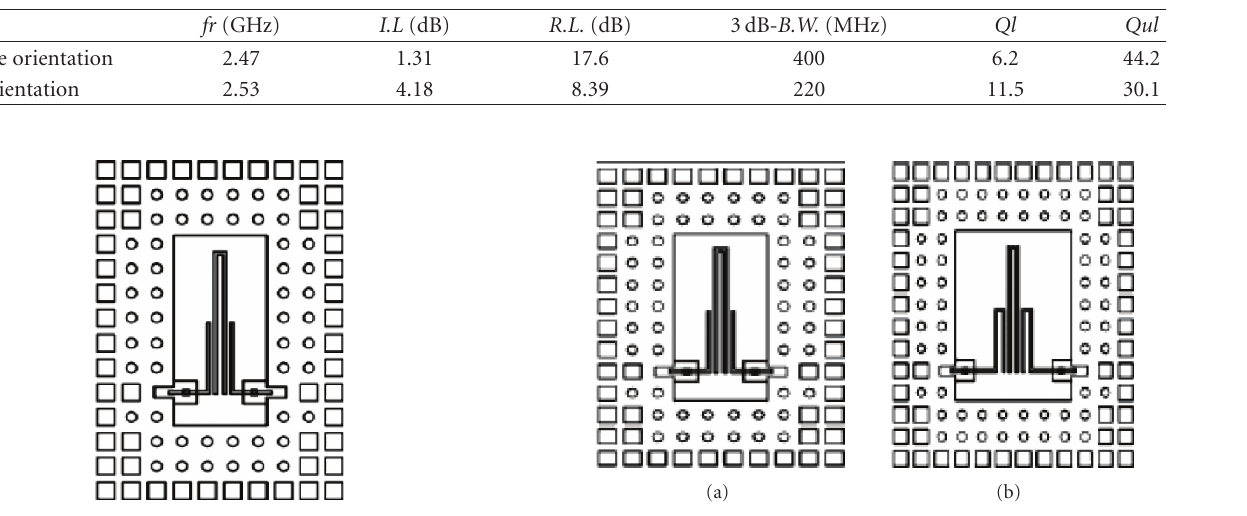
Figure 16: Layout of single hair-pin filter with parallel coupled-feed lines.